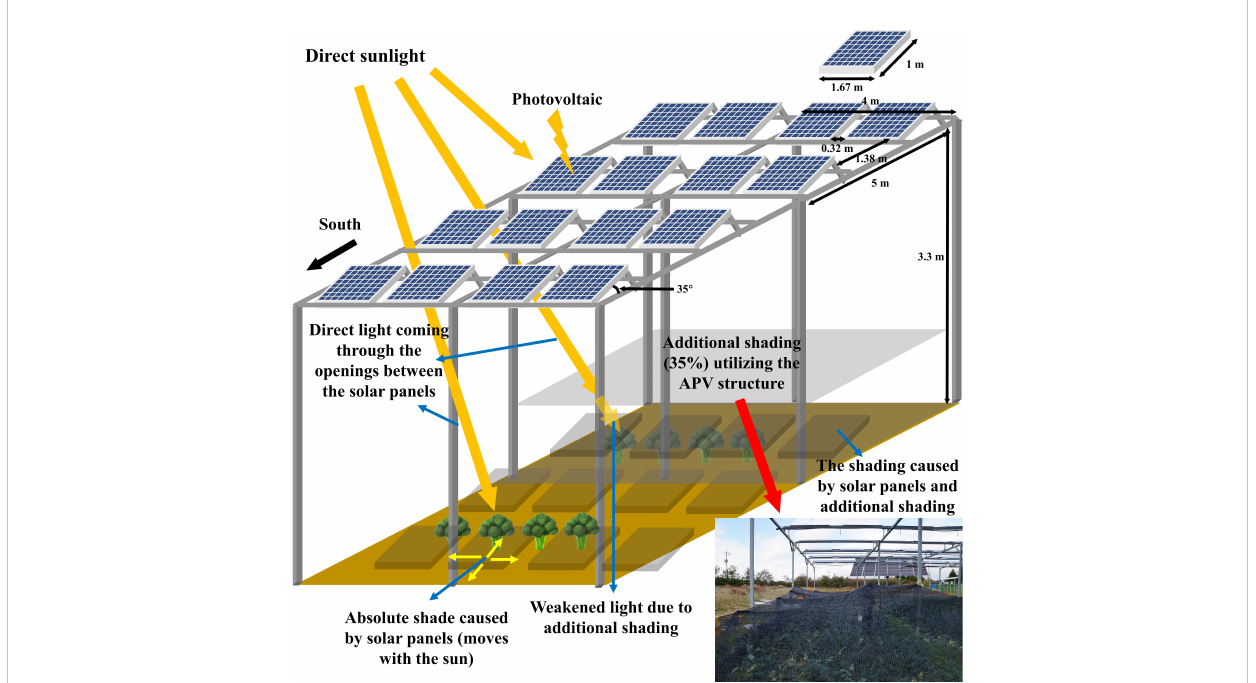
FIGURE 1 Schematic diagram of the agriphotovoltaic structure and the setting for additional shading treatment. Direct sunlight reaching to the panels is converted to electricity through the process of “ photovoltaics. ” The light entering through the gaps between the panels reach directly to the plants. When sunlight is blocked by the panels or other parts of the APV structure, an absolute shade is formed. The absolute shade moves as the relative position of the sun changes during the day. The shading curtain made of high-density polyethylene fi lm is installed on the structure and covers the plants entirely during the head extension period of broccoli. The curtain provides additional shading and blocks about 35% of the direct